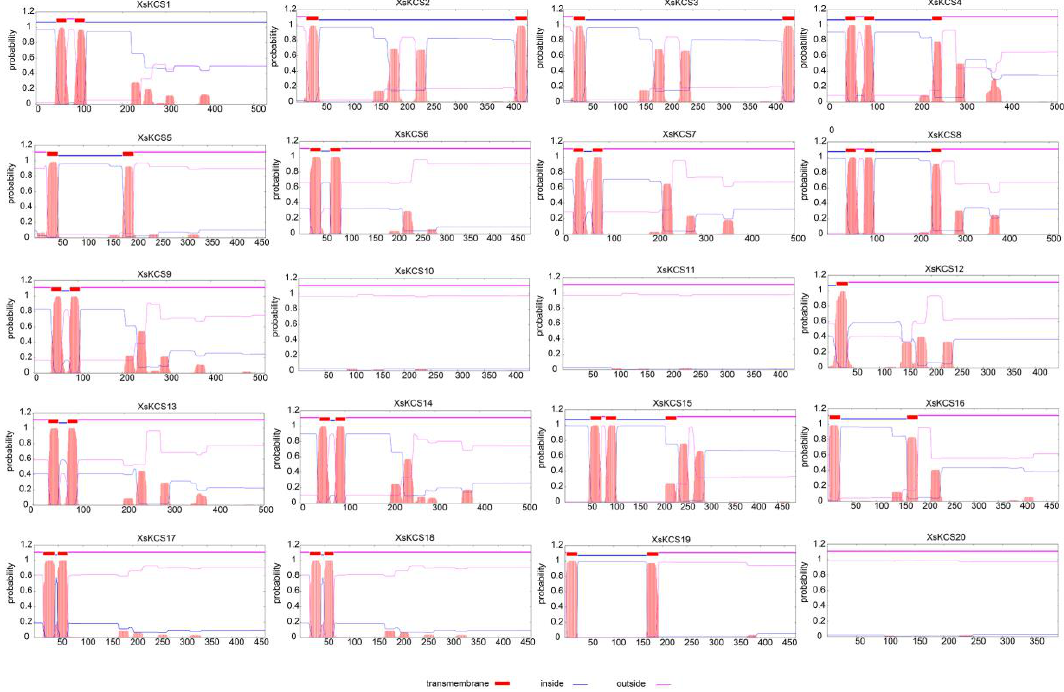
Figure 3. Transmembrane alpha helix of XsKCS proteins. The red rectangles represent the trans- membrane alpha helix, the blue thickened lines represent the amino acid in this segment that is located inside the membrane, the pink thickened lines represent the amino acid in this segment that is located outside the membrane, the scale on the left side indicates the probability of correct pre- diction.